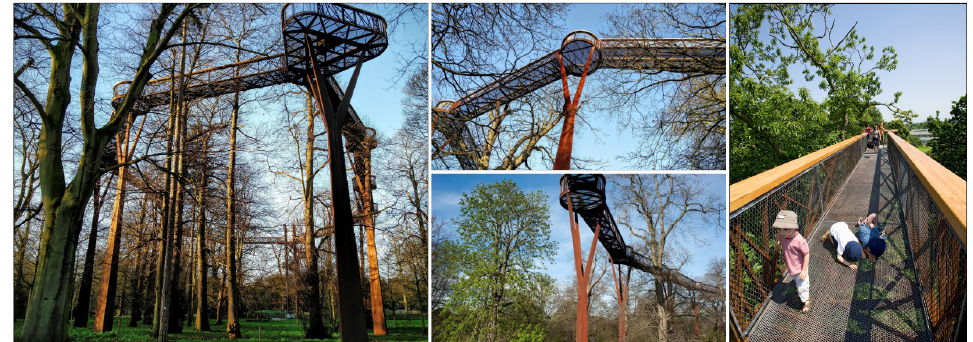
Figure 3. Photos of the Kew Gardens taken from different angles (Source: https://www.kew.org/kew-gardens/whats-in-the-gardens/treetop-walkway, accessed on 25 July 2021; and reference [41]).